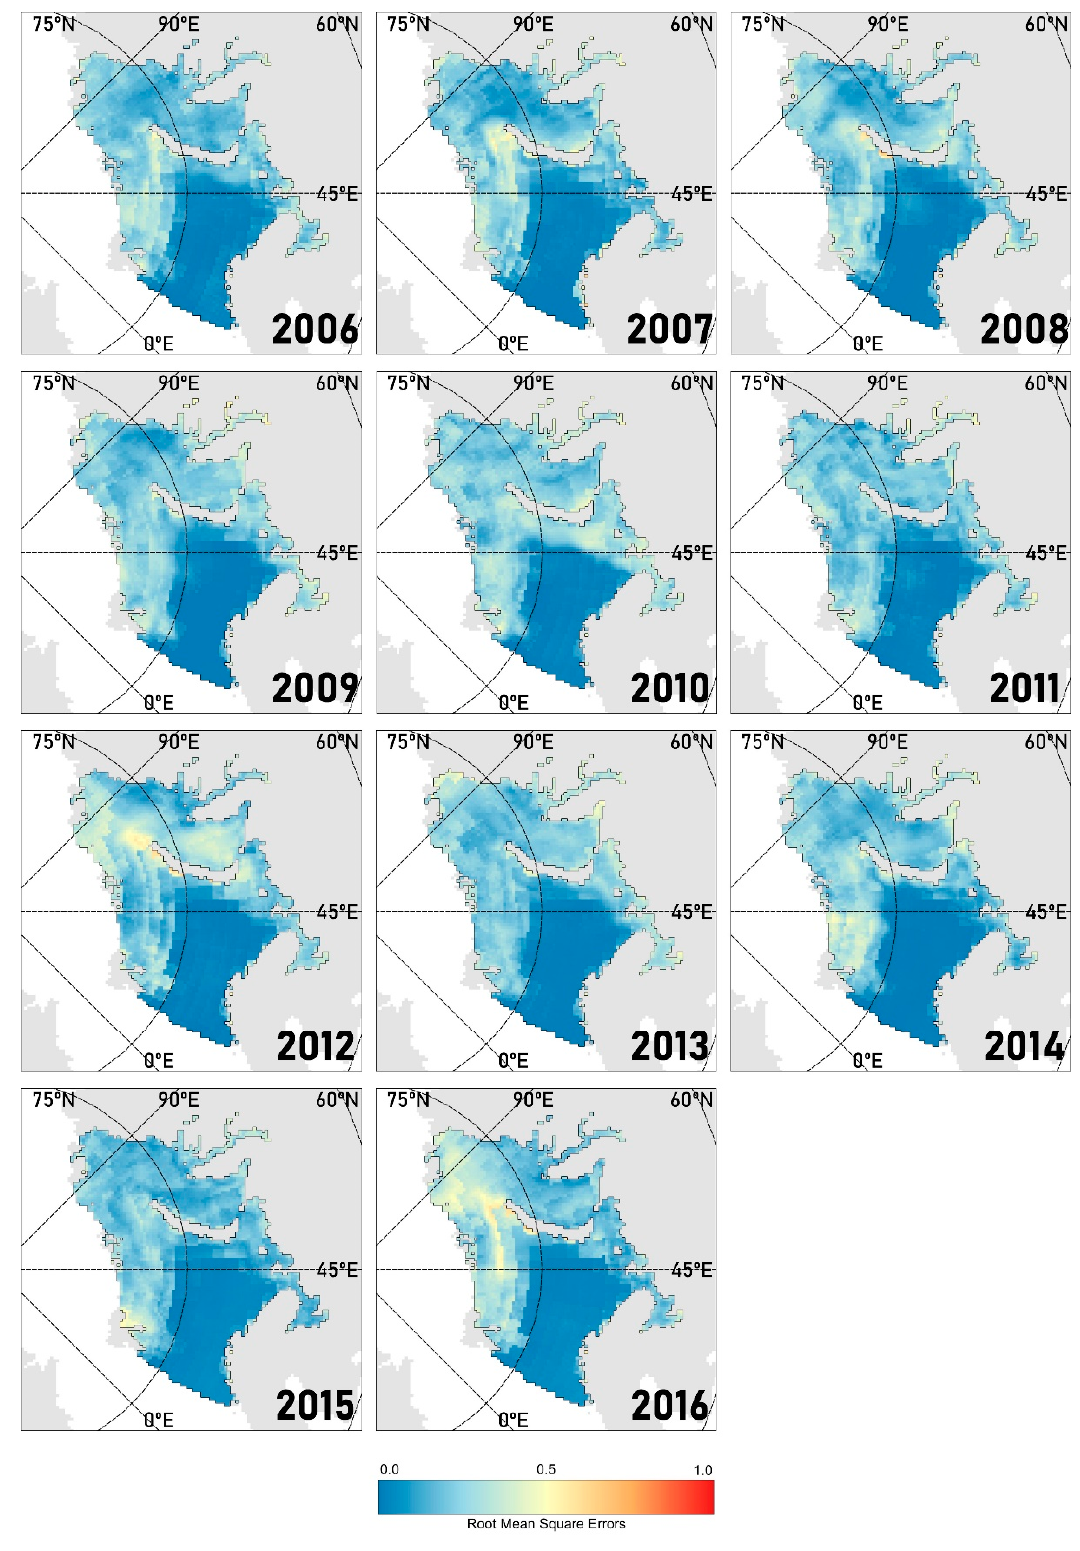
Figure 10. Twelve-month averages of root mean square error predicted by the DNN with BMA2 Figure 10. Twelve ‐ month averages of root mean square error predicted by the DNN with BMA2 ensemble for the Kara and Barents Seas during 2006–2016. ensemble for the Kara and Barents Seas during